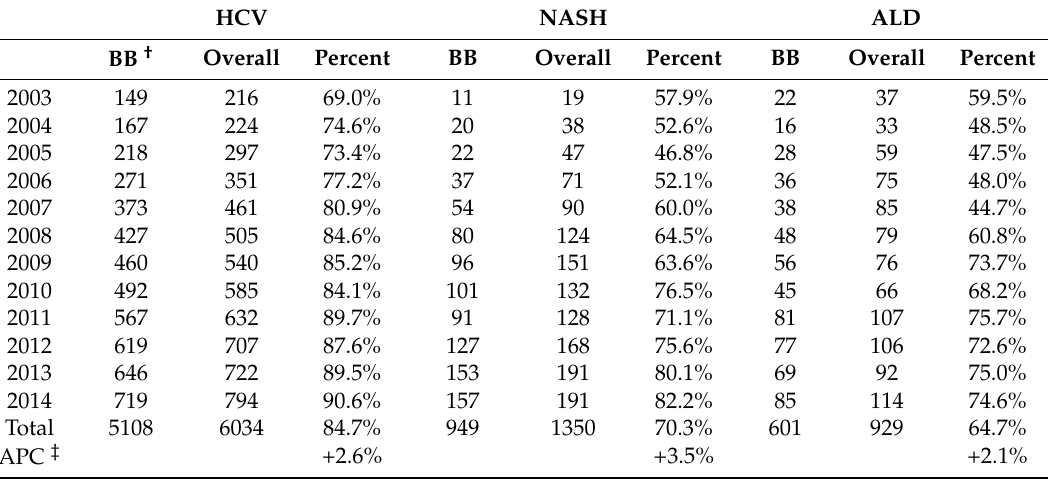
Table 1. Baby Boomer HCC Liver Transplantation Annual Trends with HCV, ALD, and NASH; UNOS 2003–2014.